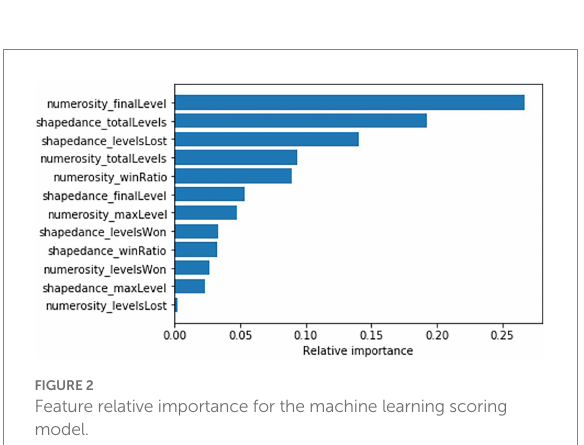
FIGURE 2 Feature relative importance for the machine learning scoring